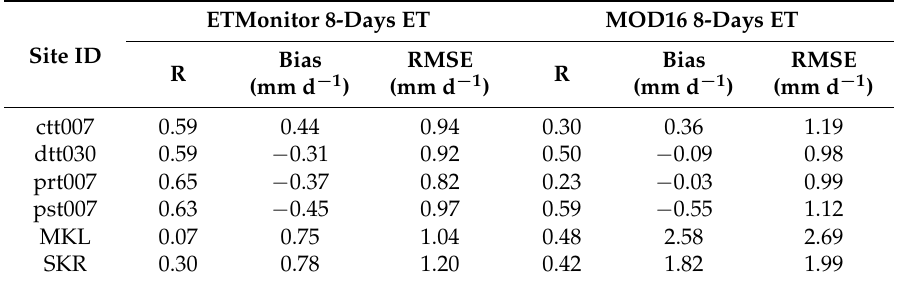
Table 4. Comparison of ETMonitor estimated 8 days ET and MOD16 8 days ET with ground observed ET.